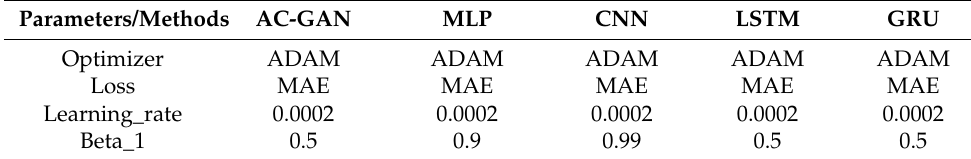
Table 5. Hyperparameter settings of the methods under comparison.